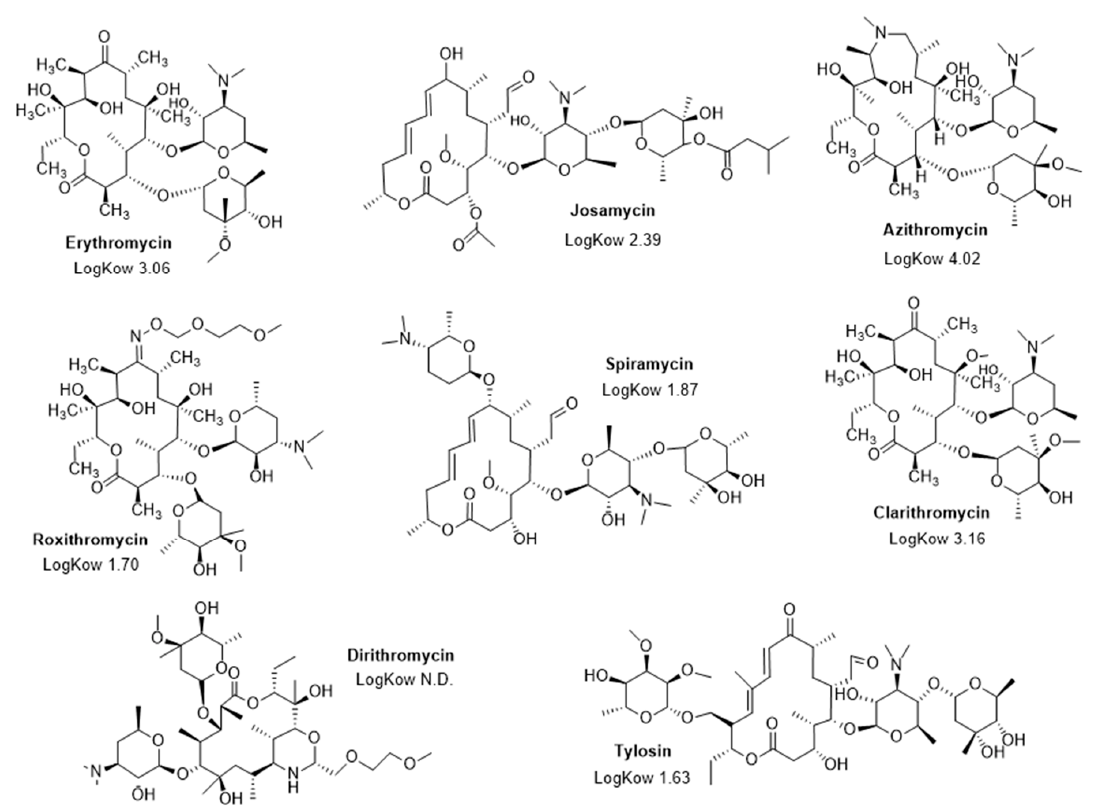
Figure 1. Structure of the macrolides used in this study and their associated LogKow values.